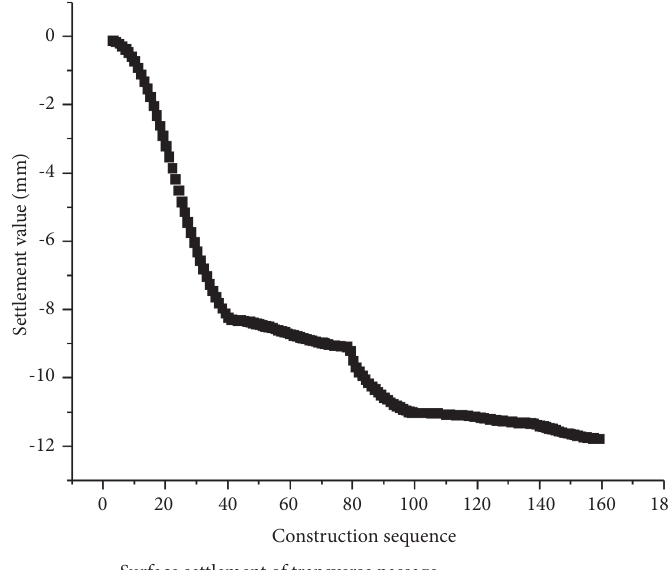
Figure 4: Time-history curve of surface settlement of transverse passage.